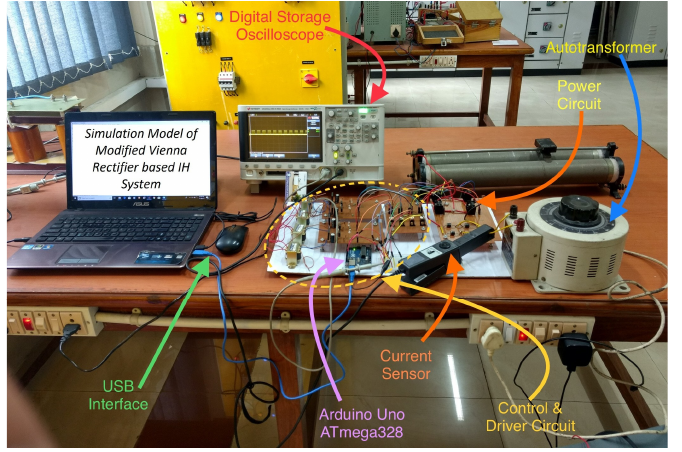
Figure 21. Experimental setup of the proposed MVR-based IH system.